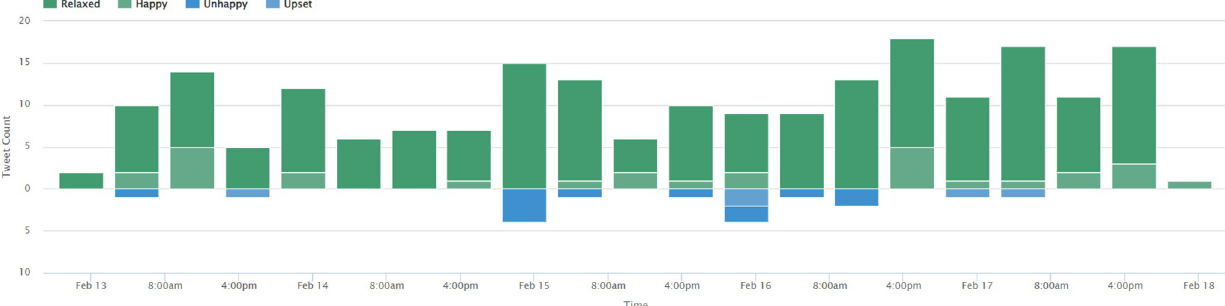
Fig 14. People emotions in new tweets dataset extracted using sentiment viz